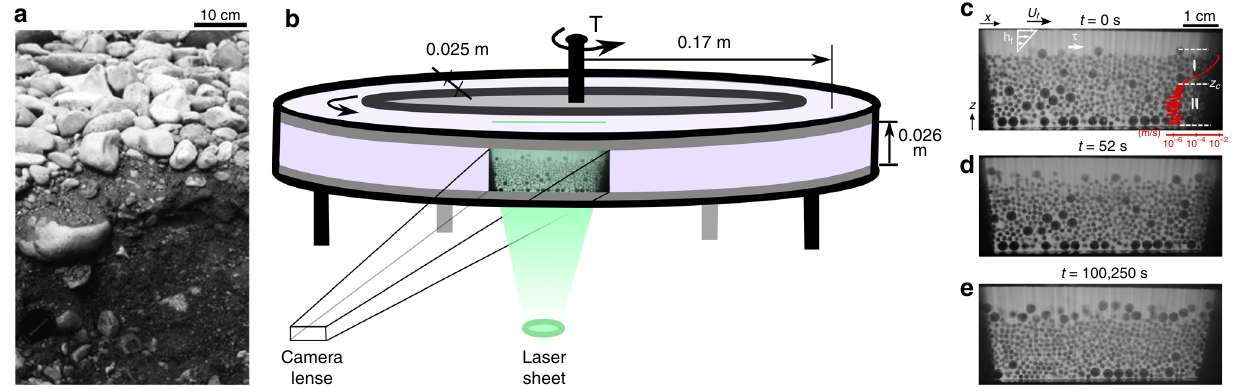
Fig. 1 Phenomenology and setup. a Bed sediment of the River Wharfe, U.K., that shows a pronounced surface armour. Photo courtesy D. Powell 58 . b Sketch of the experiment, showing position of the camera and laser plane used for imaging inside the granular bed. c – e Snapshots during armour development for τ (cid:1) ¼ 3 : 8 τ (cid:1) fl uid boundary stress, which is computed as τ = η U s cs . Also shown is the red curve shows the long-term-averaged streamwise particle velocity u x ( z ), where I and II correspond to the bed load and creep zones, respectively. The directions x and z are